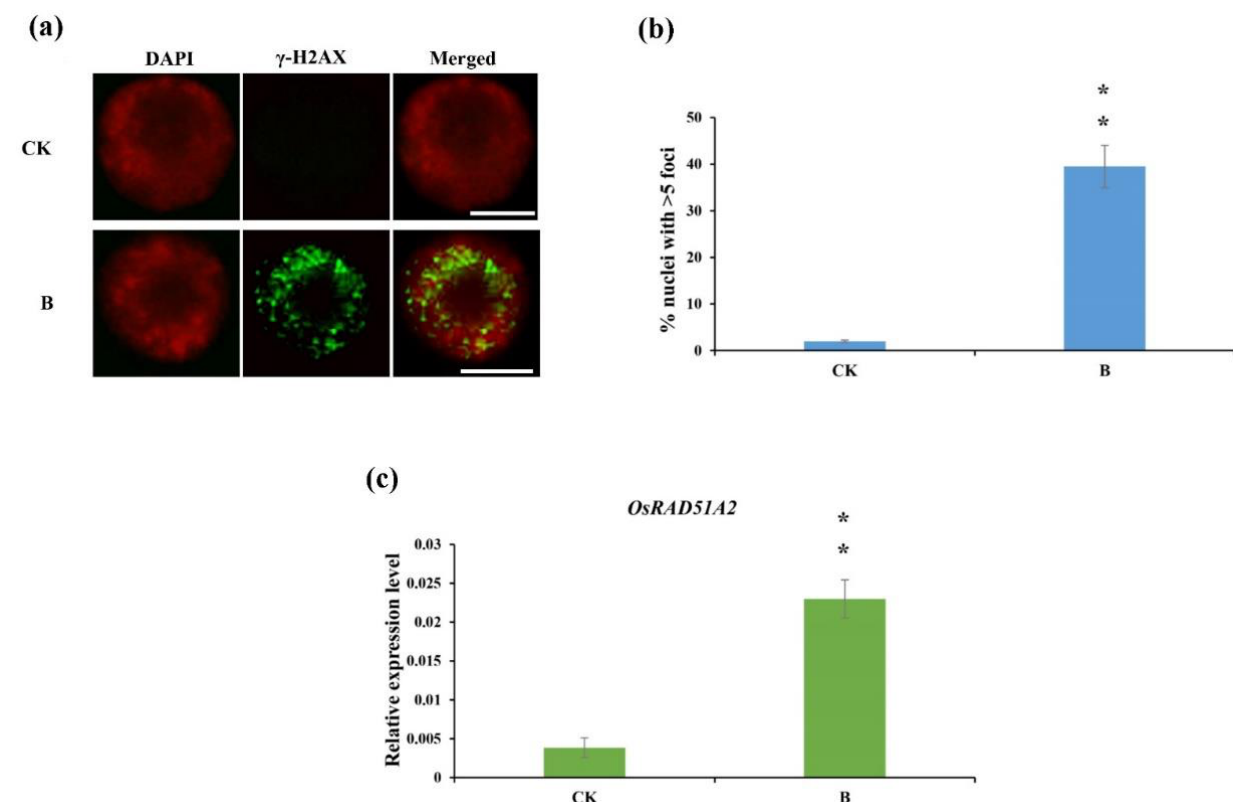
Figure 1. Immunostaining of γ -H2AX and OsRAD51A2 protein expression in rice roots. ( a ) Immunostaining of γ -H2AX (green) in rice root tip cells treated with bleomycin at concentrations of 0 (CK) or 10 (B) µ g/mL for 3 h. Chromosomes are stained with DAPI (red). Scale bar, 10 µ m; ( b ) Quantification of γ -H2AX immune signals in ( a ). Quantification of the nuclei containing γ H2AX focus signals was obtained by counting at least 100 interphase nuclei, and scoring ≥ 50 foci as positive. Data represent the means and standard deviations (SDs) of the results of three independent experiments. Student’s t-test: ** p < 0.01; ( c ) RT-qPCR analysis of OsRAD51A2 expression in rice roots treated with bleomycin at concentrations of 0 (CK) or 10 (B) µ g/mL for 24 h. Data represent the means ± SDs of three replicates. Student’s t-test: ** p < 0.01.